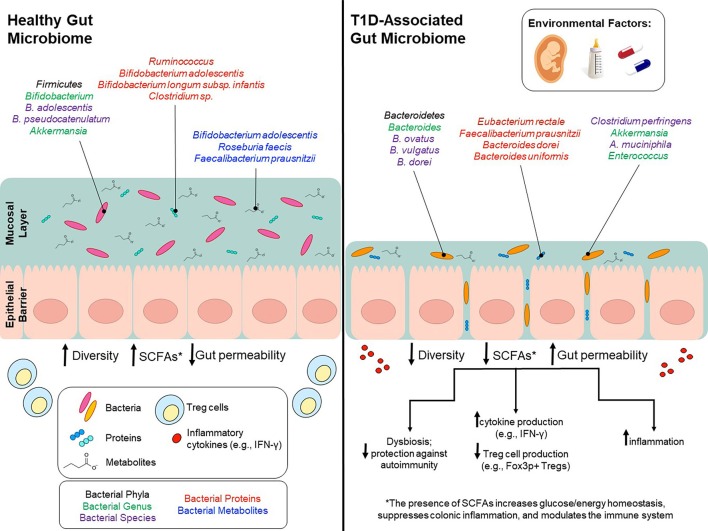
Environmental factors modulate gut microbiota and potentially contribute to T1D onset. Environmental factors, such as birth mode, diet early in life, and use of antibiotics can influence gut microbiota composition and can to lead to lower bacterial diversity, decreased SCFA production and increased gut permeability. Bacterial phyla/genus/species that are affected by environmental factors and differ between T1D patients and healthy controls are depicted in the colors black/green/purple, respectively. Bacterial genus/species that have been identified in proteomic analyses and are increased in either T1D patients or healthy controls are shown in red. Bacterial genus/species that have been identified in metabolomics analyses and are increased in either T1D patients or healthy controls are shown in blue.